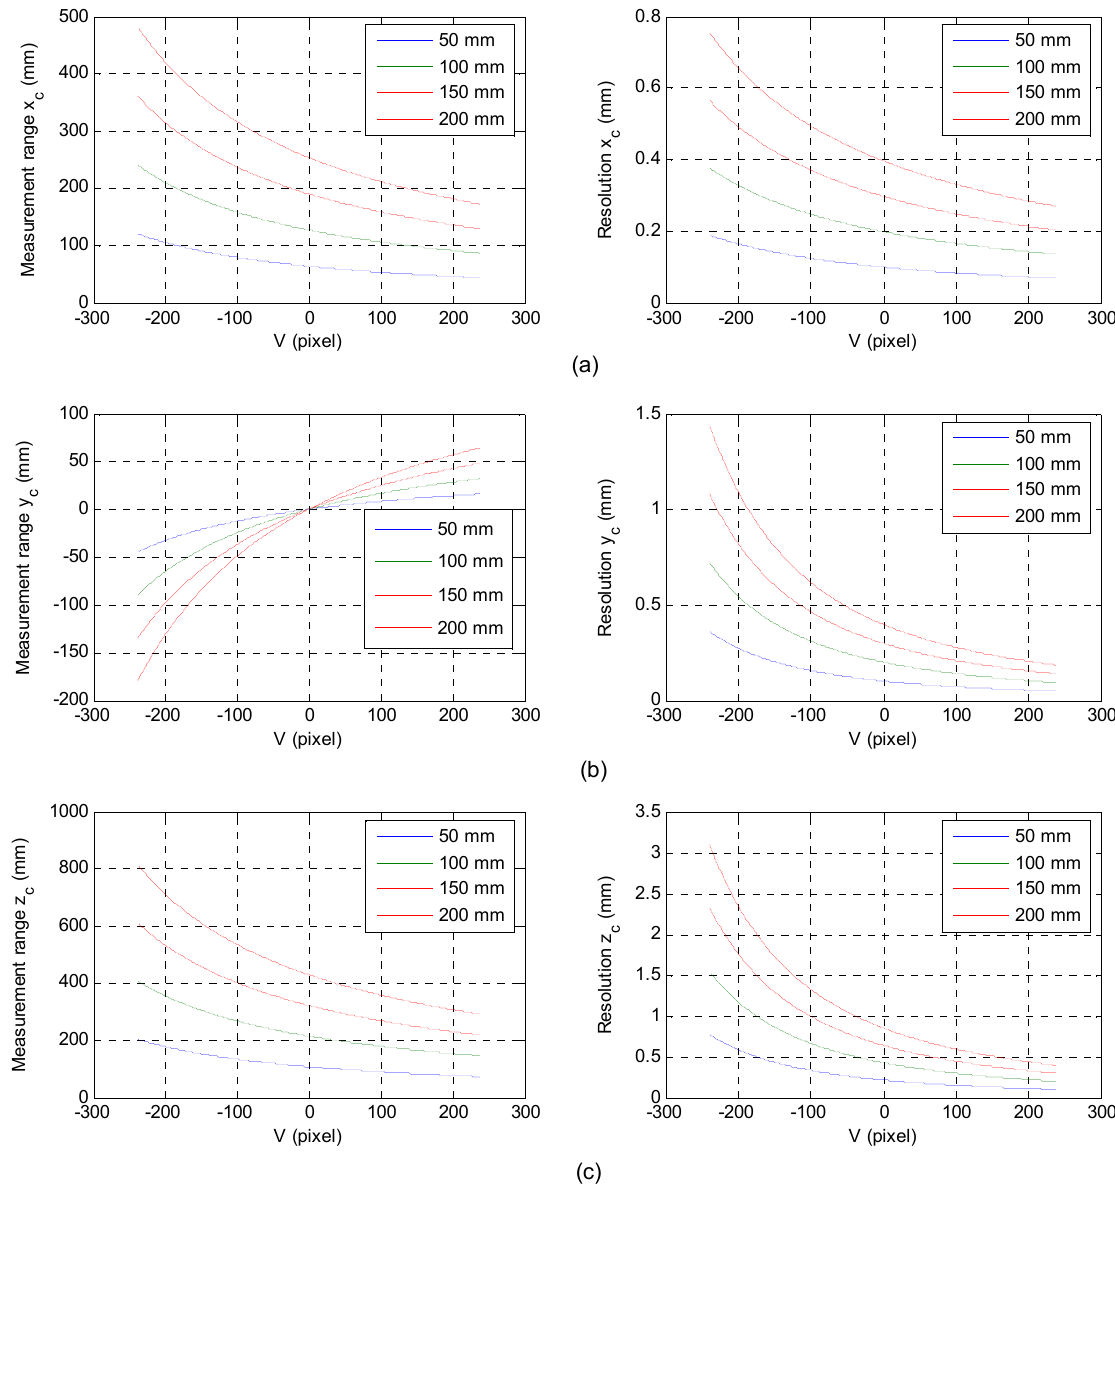
Figure 4 . Measurement range and resolution for different baseline distances, where the projection angle is 25